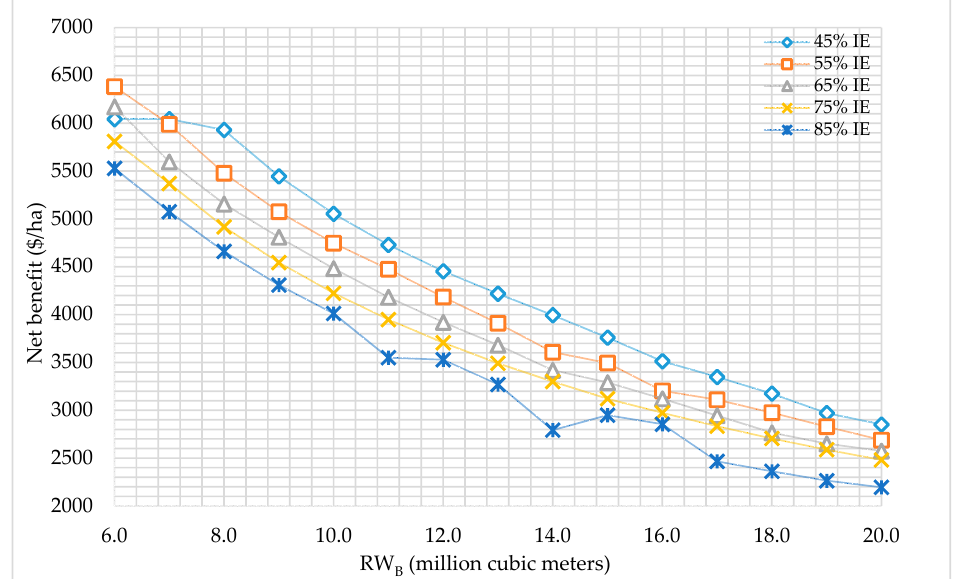
Figure 7. Net benefit per hectare ($/ha) predicted using reclaimed water type B (RW B ) with five different irrigation efficiencies (IEs).